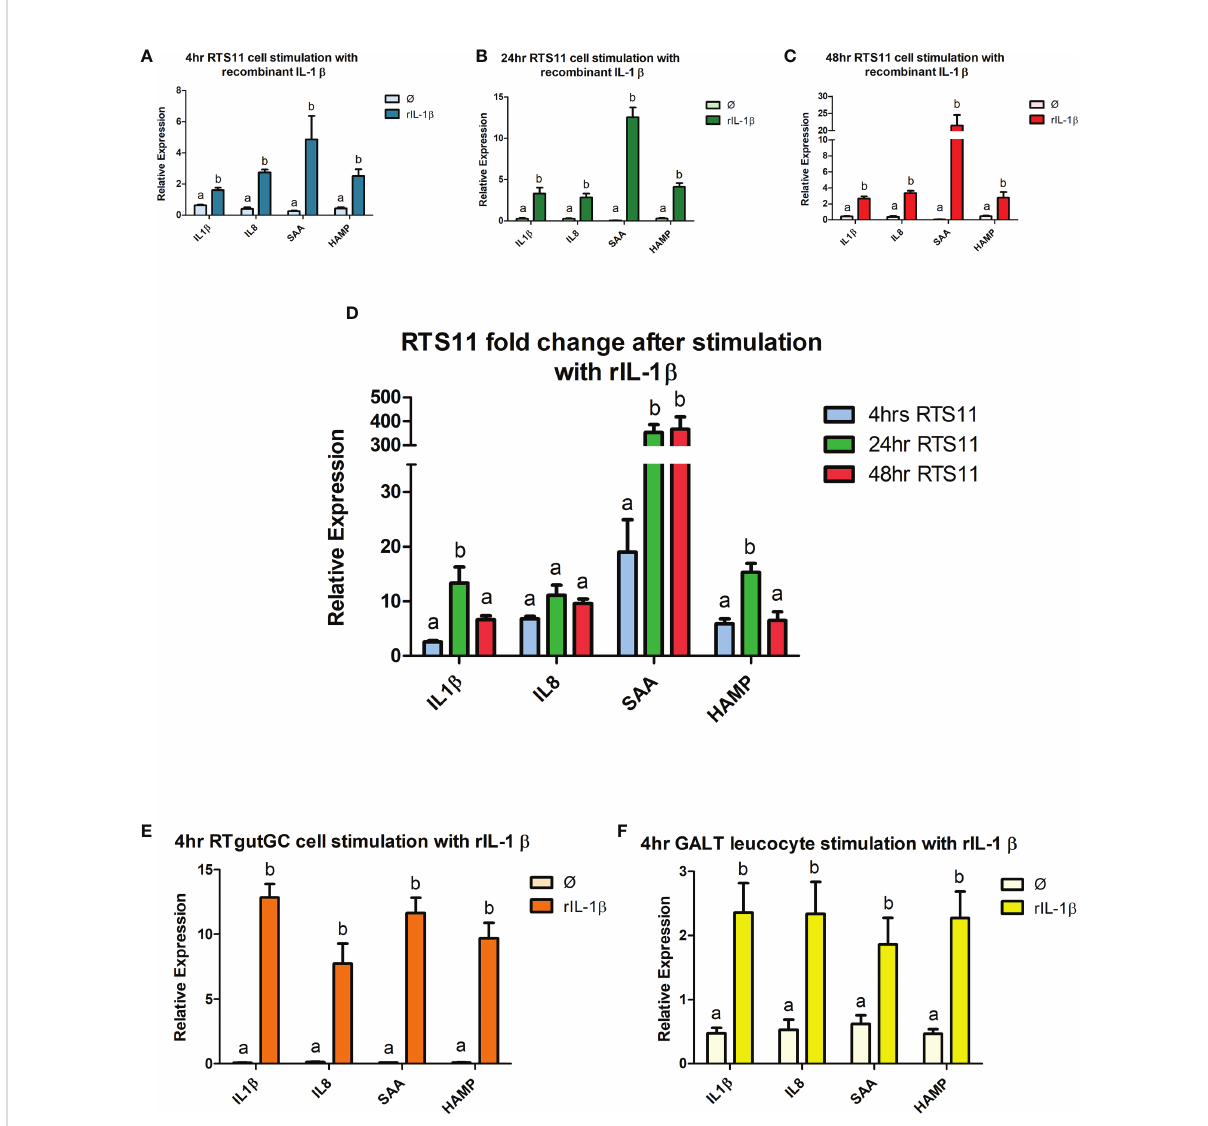
FIGURE 3 RTS11, RTgutGC and GALT leucocyte response to rIL-1 b . (A) RTS11 4hr rIL-1 b stimulation showing relative expression. (B) RTS11 24hr rIL-1 b stimulation showing relative expression. (C) RTS11 48hr rIL-1 b stimulation showing relative expression. (D) RTS11 Fold Change between time points (4, 24 and 48 hr). (E) RTgutGC 4hr rIL-1 b stimulation showing relative expression. (F) GALT leucocyte 4hr rIL-1 b stimulation showing relative expression. For relative expression samples were compared between stimulated and unstimulated samples. a and b denote a signi fi cant difference where p <